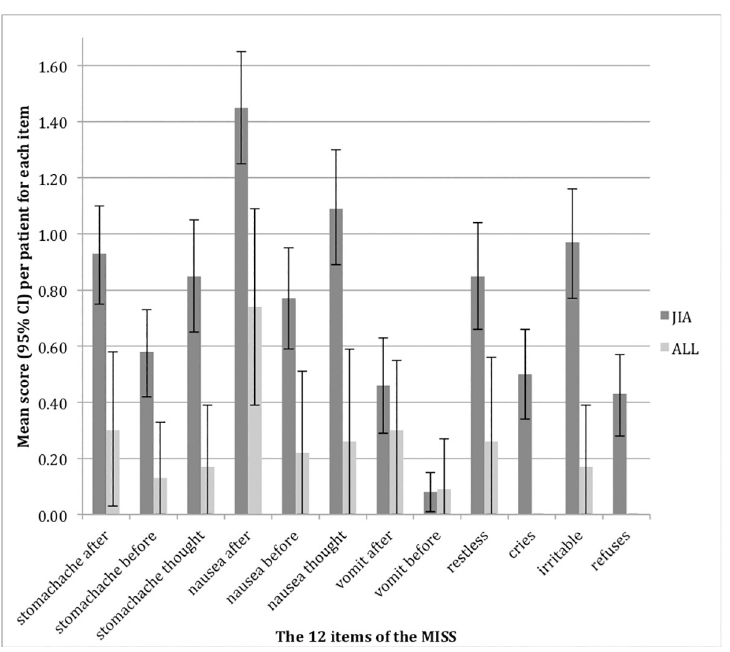
Fig 3. The methotrexate intolerance severity score–the juvenile idiopathic arthritis group and the acute lymphoblastic leukaemia group. Bar chart illustrating the mean scores (with 95% confidence interval) for each of the 12 items of the methotrexate intolerance severity score (MISS) for the juvenile idiopathic arthritis (JIA) group (n = 120) and the acute lymphoblastic leukaemia (ALL) group (n = 23). scores and the MTX doses in either of the disease groups (JIA group: r ALL group: r (21) = 0.34; p = 0.11), and no significant difference was found between the s